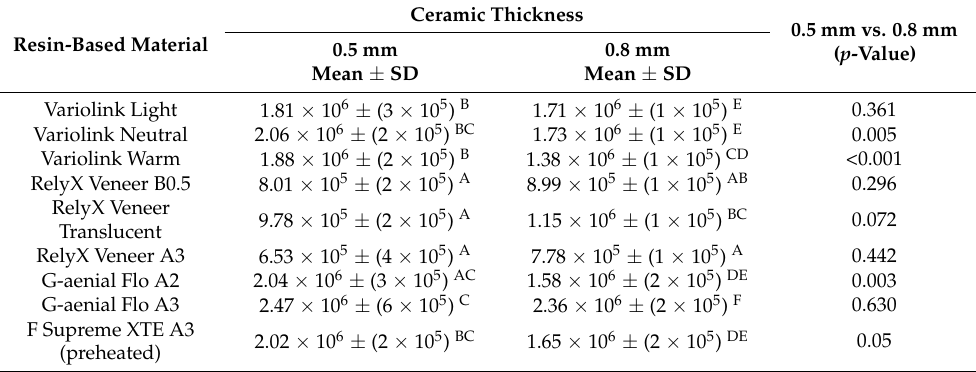
Table 2. Mean fluorescence values (arbitrary unit, a.u.) and standard deviation (SD) obtained for bonded ceramic samples according to the resin-based luting agent and the feldspathic ceramic thickness (n = 10). For each column, different letters indicate significantly different fluorescence mean values among luting agents used for each feldspathic ceramic